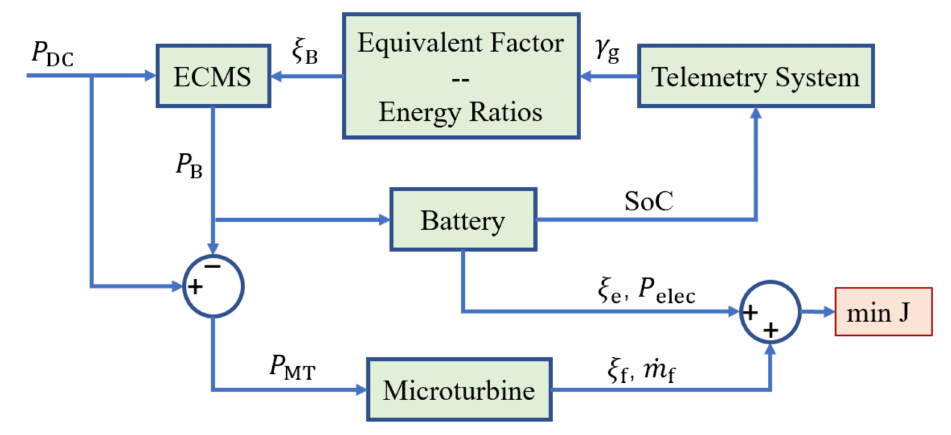
Figure 13. The flowchart of telemetry-equivalent consumption minimization strategy